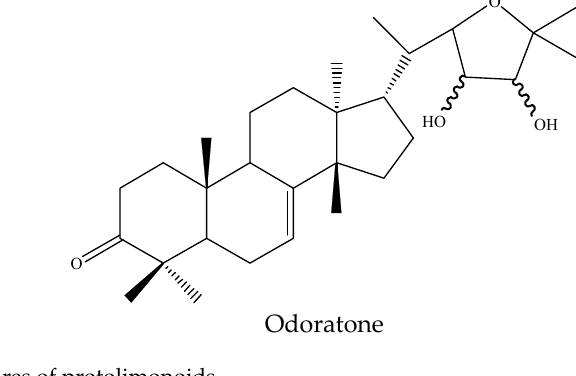
Figure 20. The structures of protolimonoids.